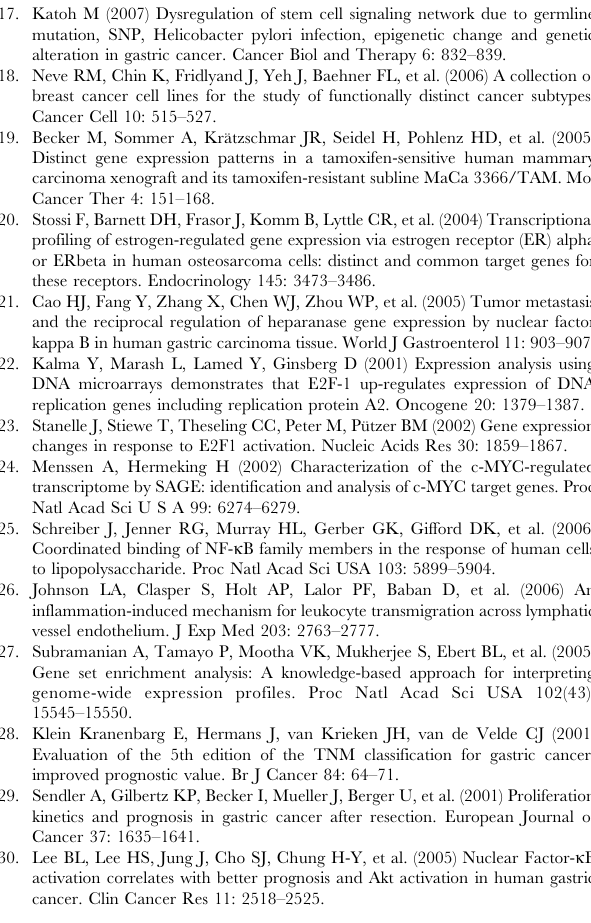
Table S9 Histopathological data for Cohort 2 of 200 tumors from Singapore.